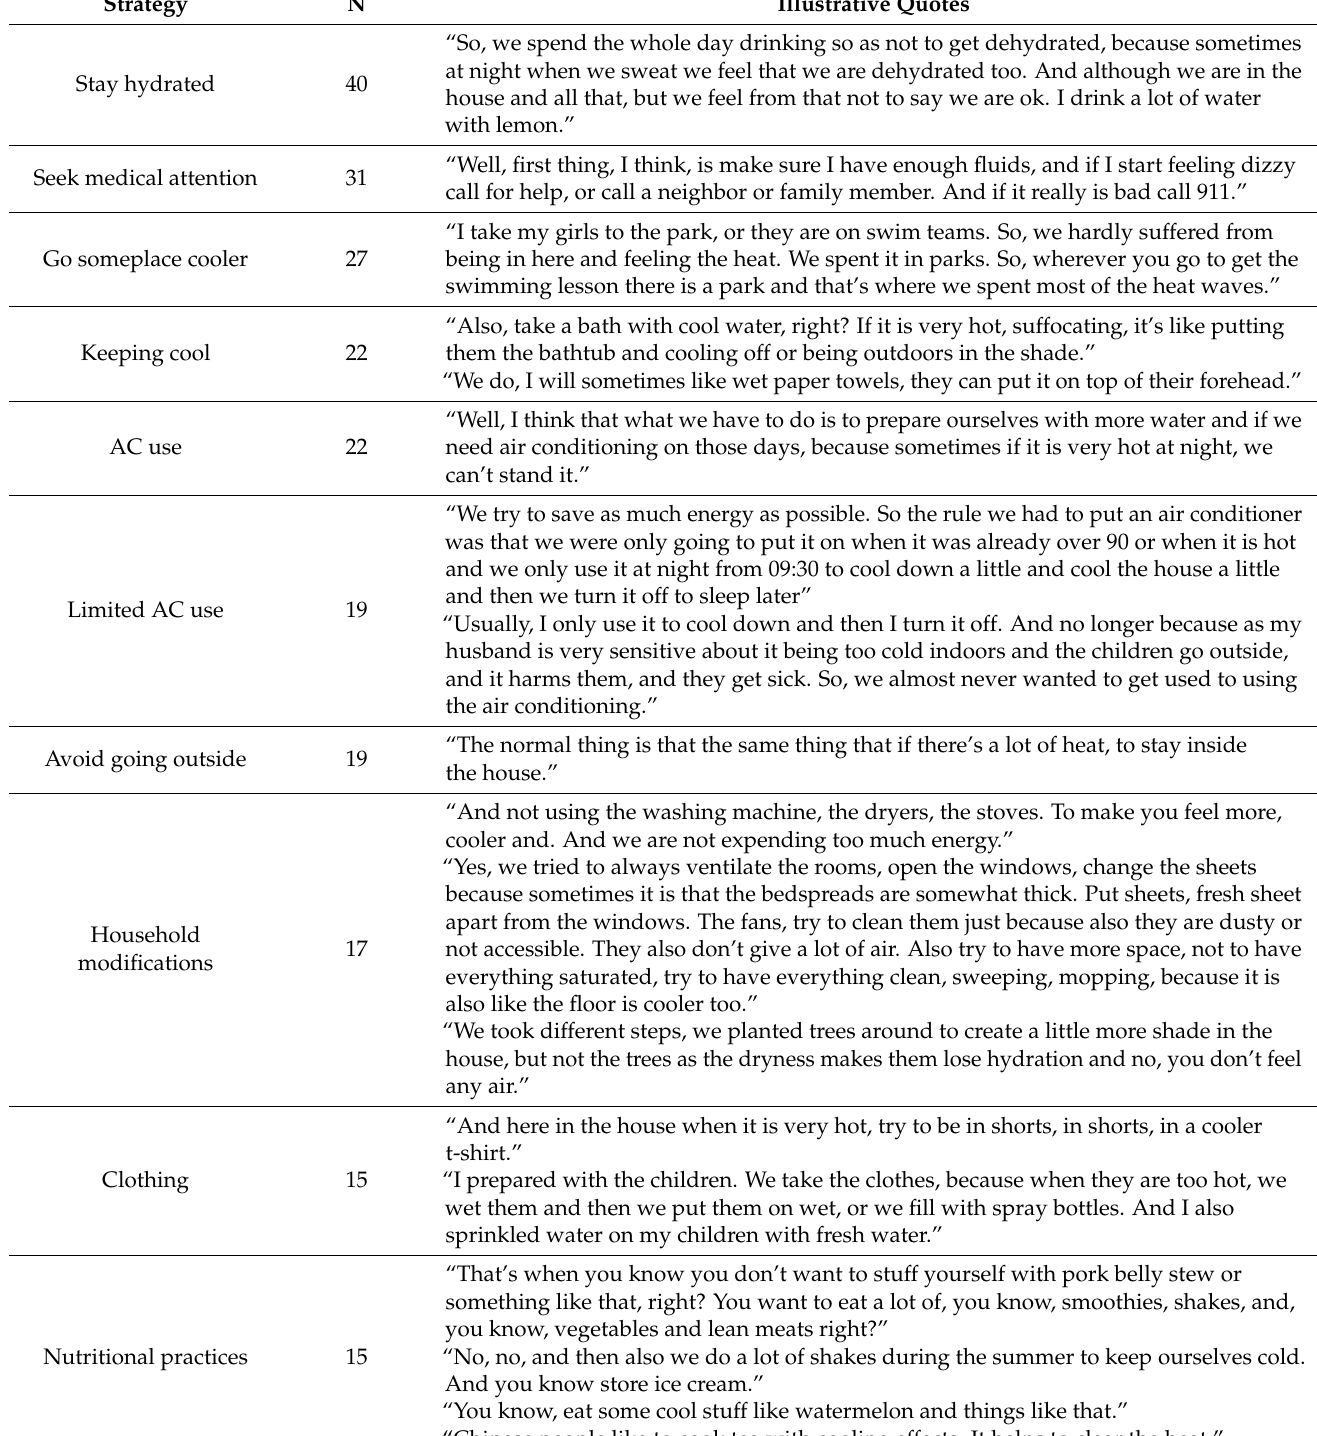
Table 3. Heat adaptation